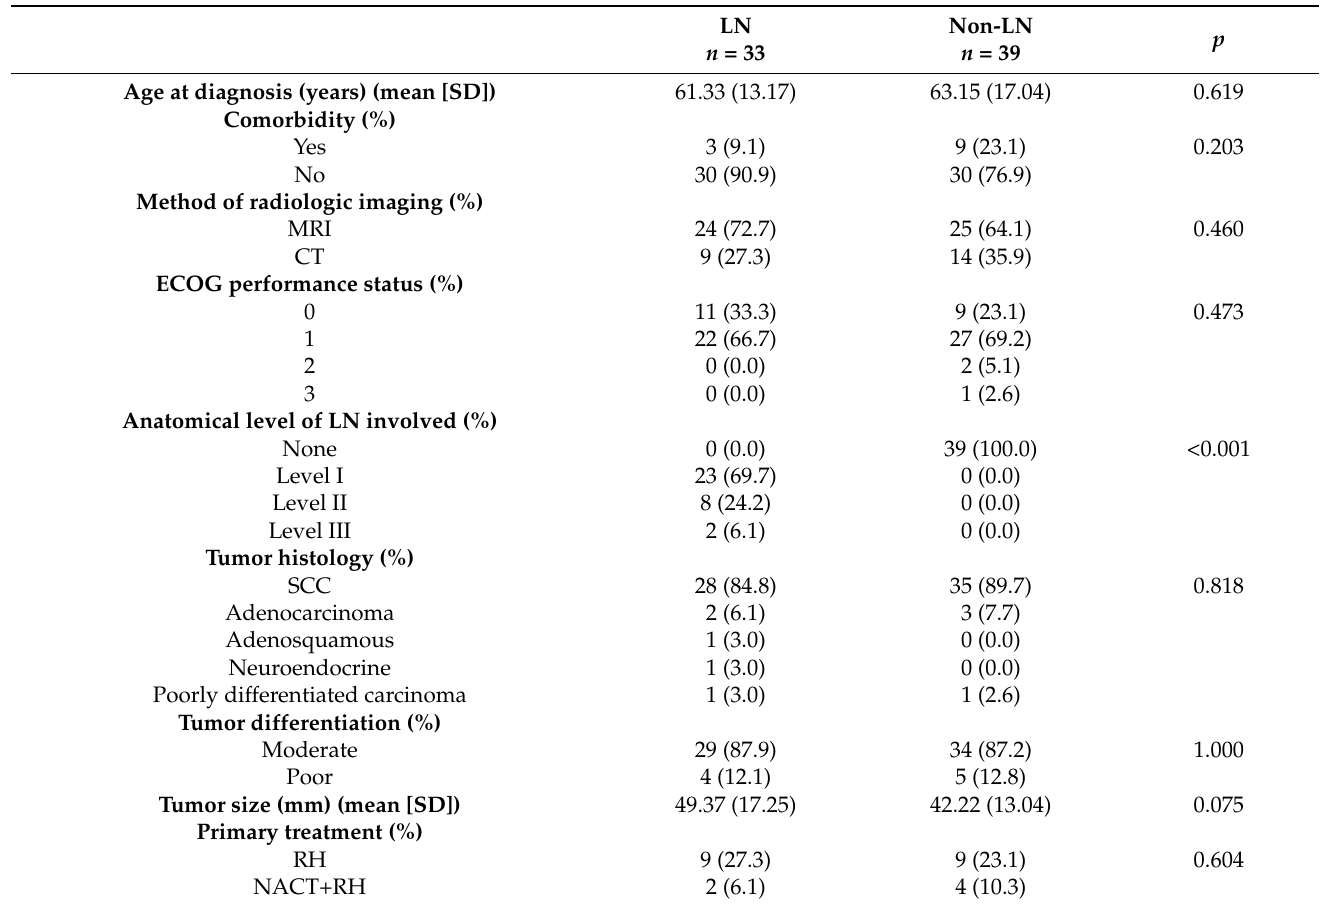
Table 1. Demographic and clinicopathological characteristics of patients with clinical stage IIB CC.